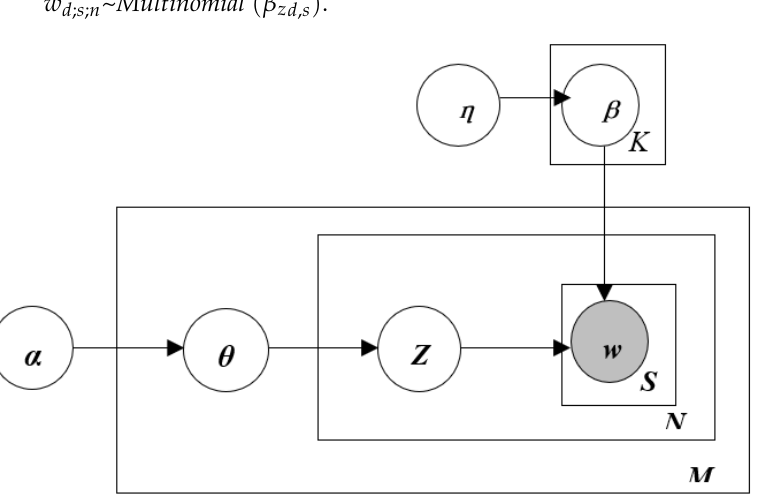
Figure 1. The graphical representation of the Sent-LDA model.